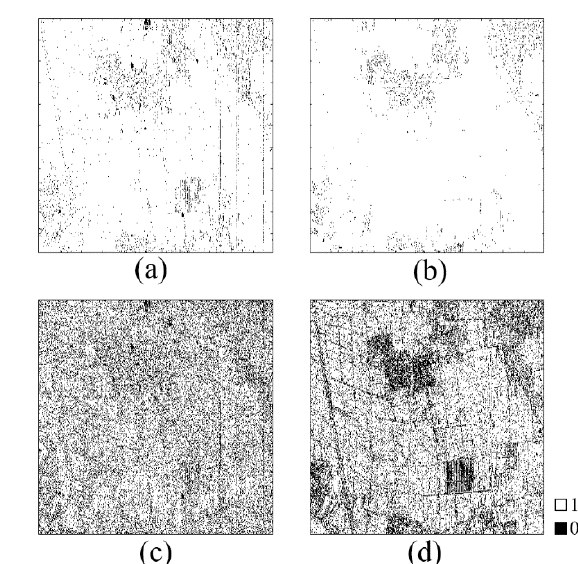
Figure 4 . Results of different distribution target extraction methods, (a) Span, (b) PCC, (c) Helix, (d) KS-DTEM.